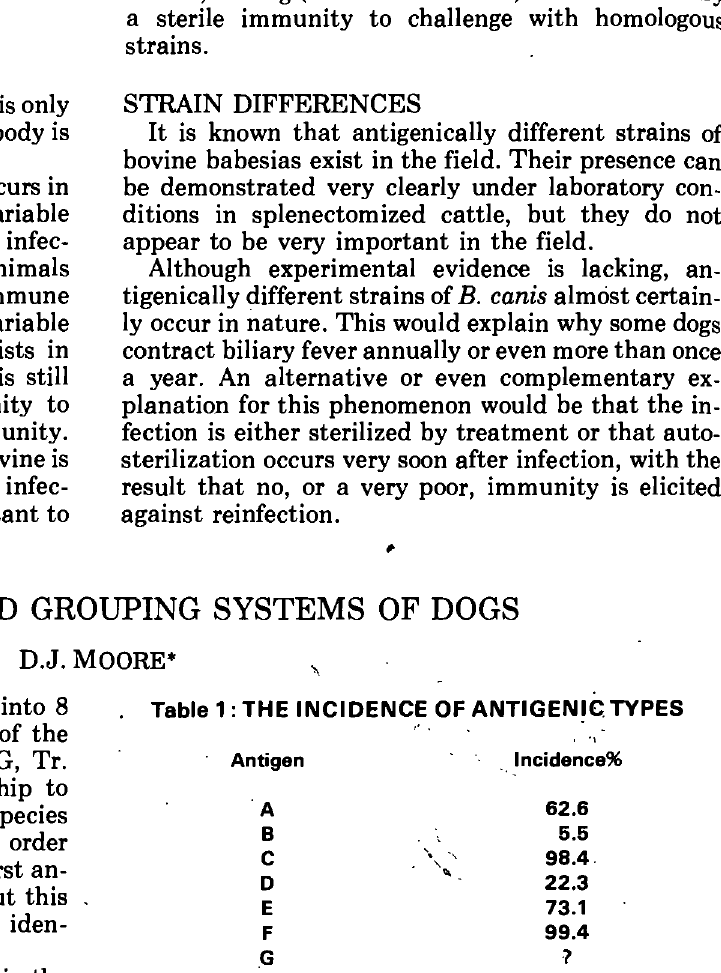
Table 1: THE INCIDENCE OF ANTIGENIC TYPES